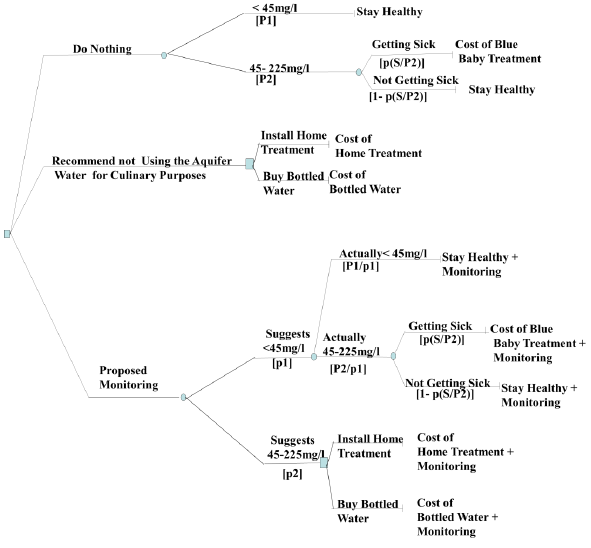
Fig. 3. Decision tree model for the scenario where people fully Figure 3. Decision tree model for the scenario where people fully abide by DM abide by DM recommendations. recommendations.